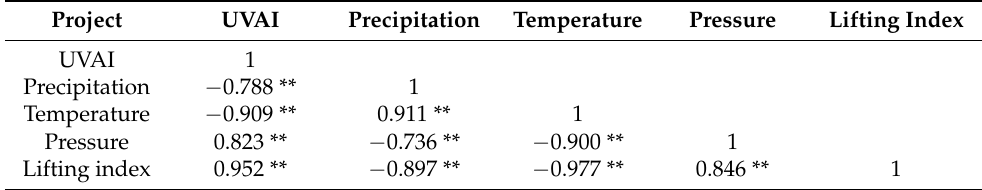
Table 1. Pearson correlation-standard